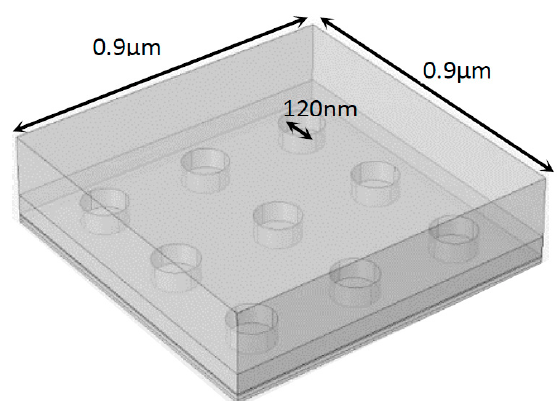
Figure 2. Layout of the 3D a-Si solar cell with the inclusion of an aluminum nanoantenna.